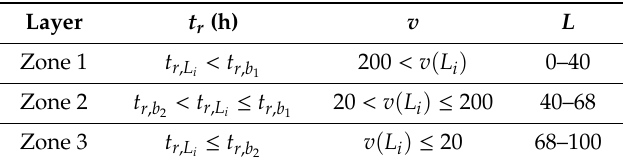
Figure 8. Vertical distribution of the RTT. Table 1. Conditions of the zones.